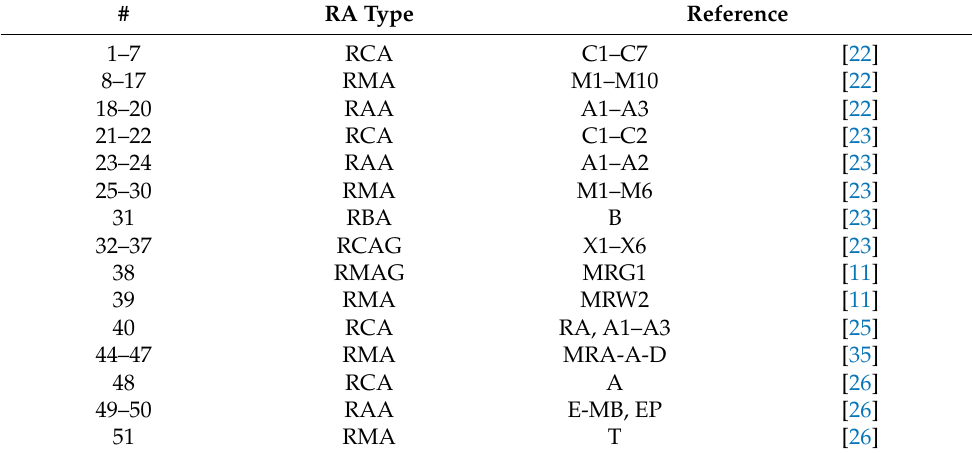
Table 1. RA types in the studies considered.